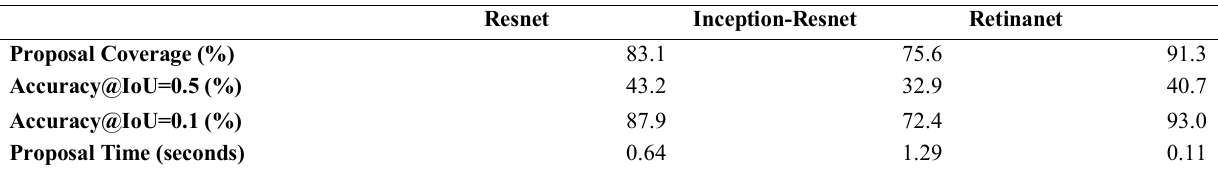
Table 2: Results of each accuracy metric for network architectures. Computed proposal times on a Nvidia 1060 GPU are also shown. Retinanet can be seen here to be the highest performing network